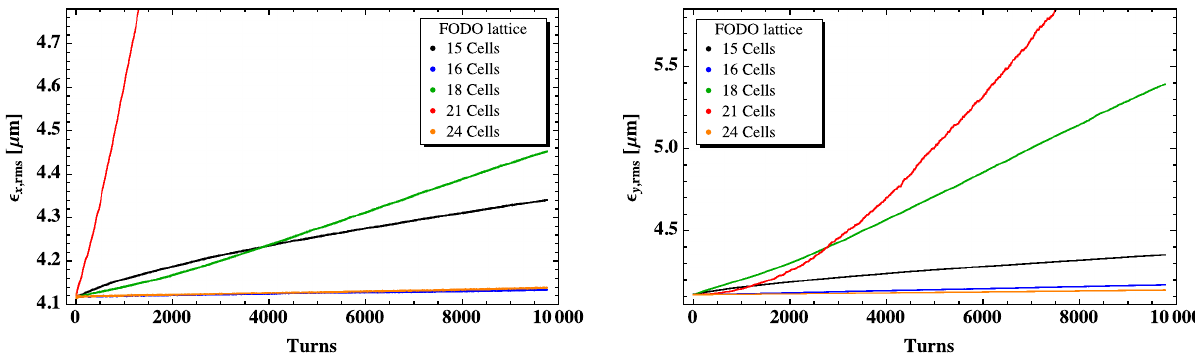
FIG. 11. Time evolution of horizontal (left) and vertical (right) rms emittance for the regular FODO cell lattices consisting of 15, 16, 18, 21 and 24 cells.